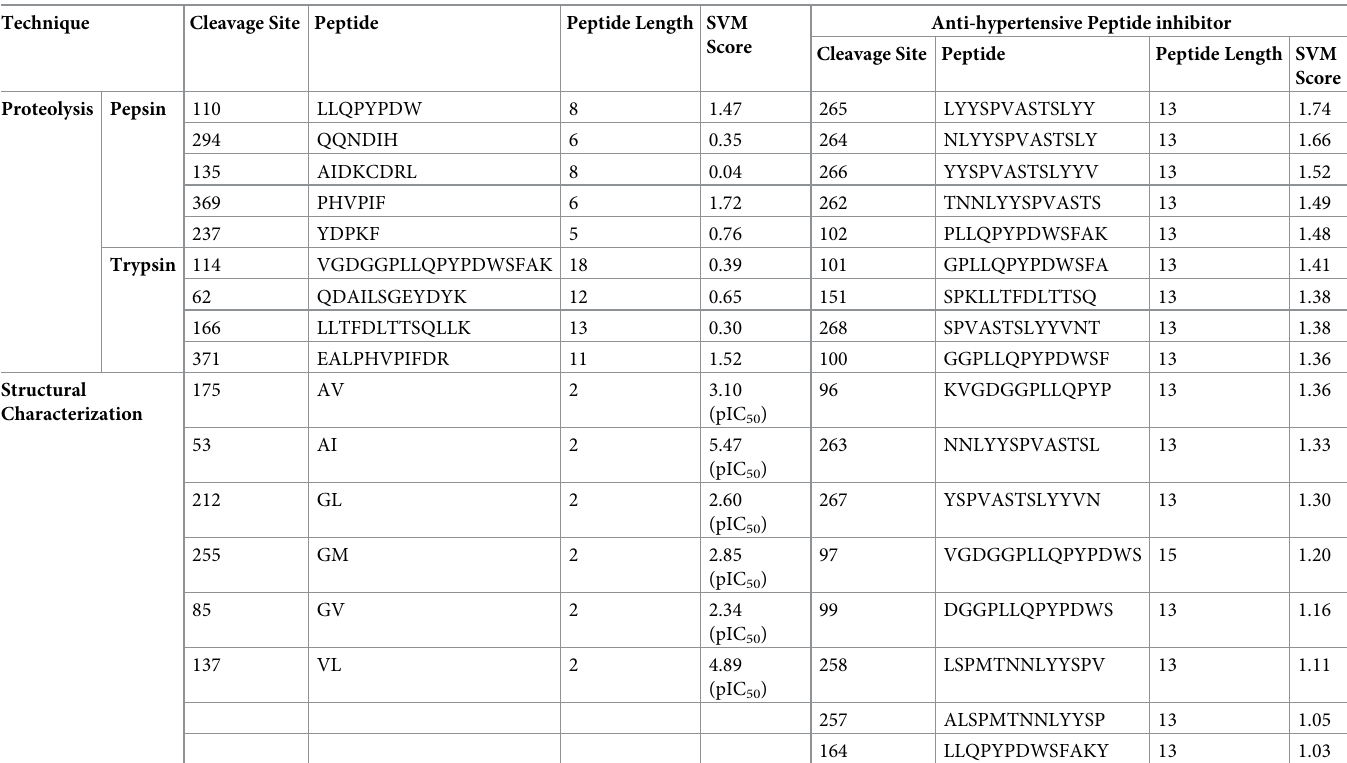
Table 1. Derived peptides having anti-hypertensive activity. Technique Cleavage Site